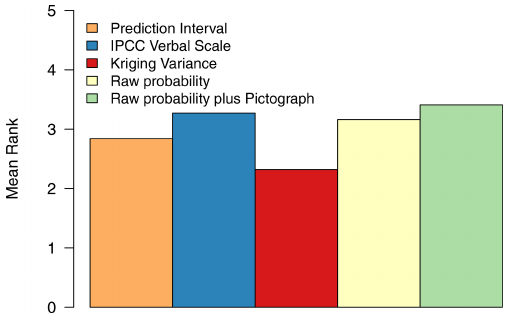
Figure 6. Ranking of posters in terms of the most effective at com- municating uncertainty about spatial